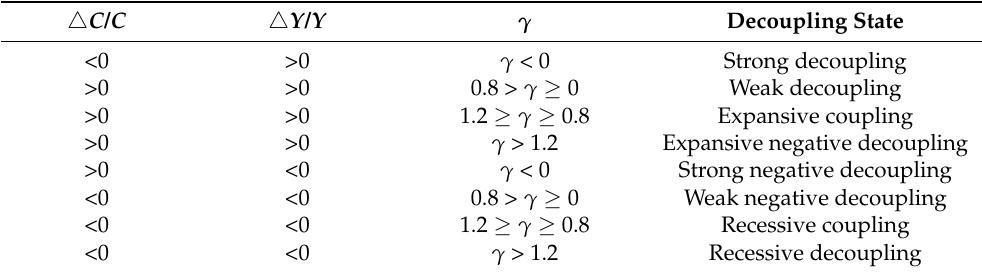
Table 1. Levels of decoupling state